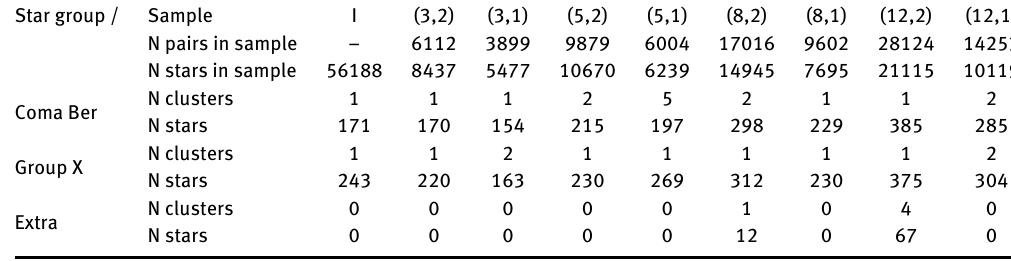
Table 1. Results of application of clustering algorithm to different samples Star group /